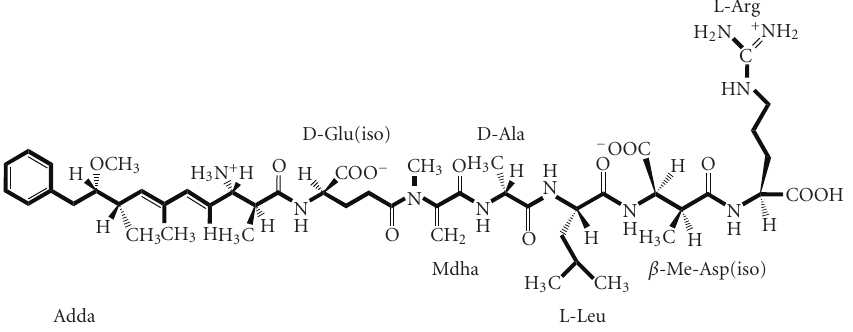
Figure 5: Structure of linearized